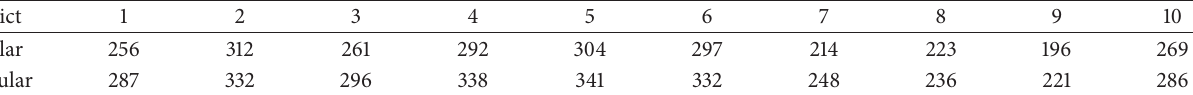
Table 2: Grids difference for 10 districts.